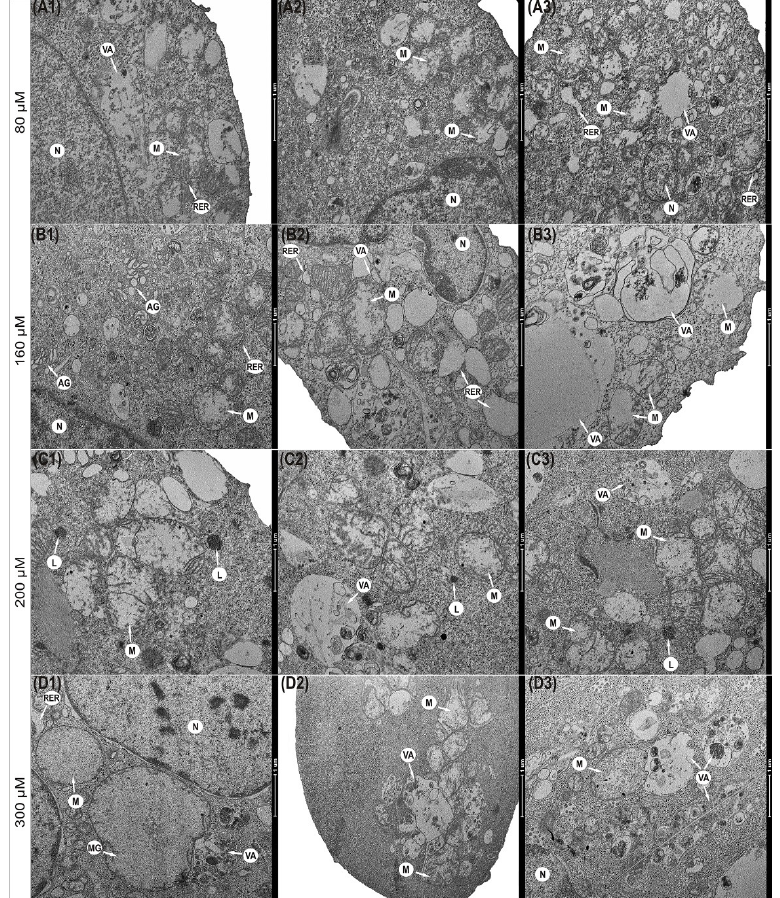
Figure 3. Ultrastructural changes in mitochondria of HeLa cells encumbered for 48 h with physcion. ( A1 – A3 ) Cell with swollen mitochondria and dilated channels of rough endoplasmic reticulum (80 μ M). ( B1 – B3 ) Swollen mitochondria with clear matrix, short cristae (160 μ M), mitochondria with membrane rupture and infused into the cytoplasm with 200 μ M ( C1 – C3 ) and 300 μ M ( D1 – D3 ). Megamitochondria present in the cytoplasm ( D1 ) (300 μ M) with complete loss of mito- chondrial cristae. N—Nucleus, M—mitochondria, MG—megamitochondria, AG—Golgi apparatus, RER—rough endo- plasmic reticulum, VA—autophagic vacuoles, L—lysosomes. Magnification ×11,500.